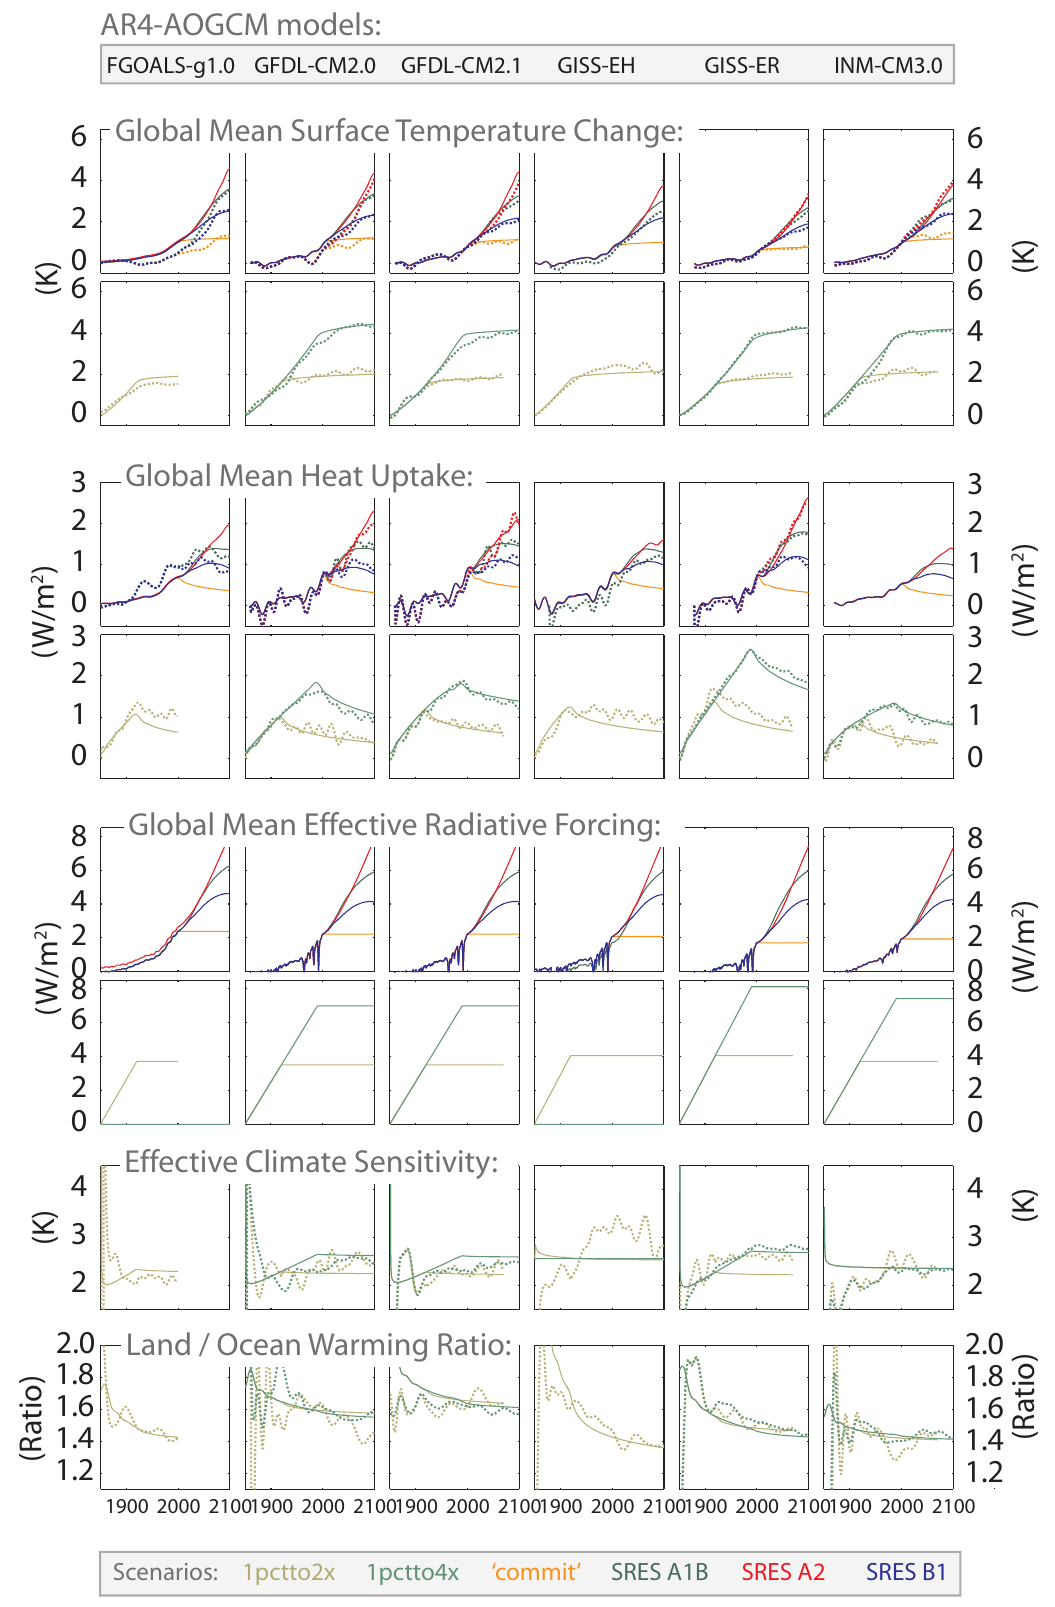
Fig. B2. As Fig. B1, but for another six of the 19 emulated CMIP3